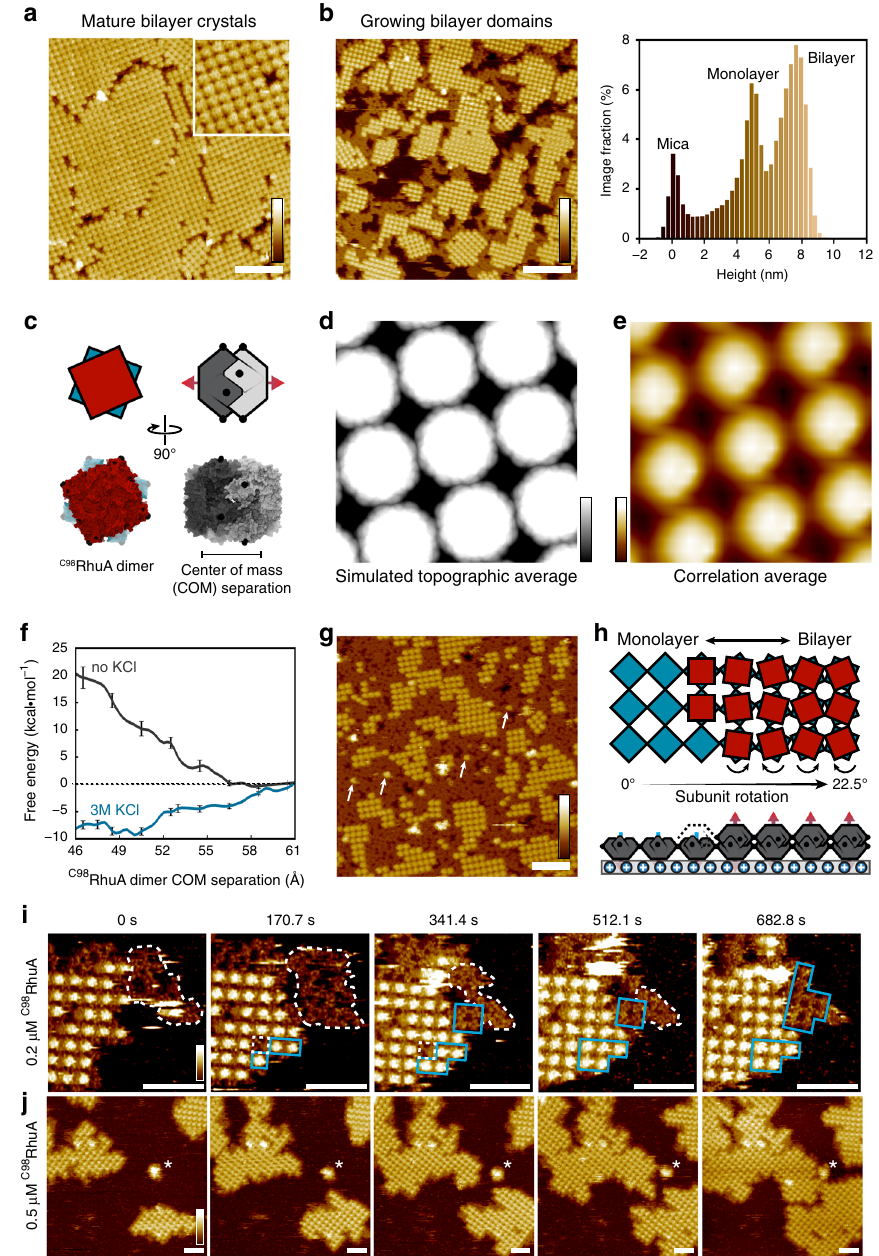
Fig. 3 Hierarchical self-assembly of bilayer C98 RhuA crystals. High-resolution AFM images of a , mature and b , growing bilayer crystals (0.4 – 0.5 μ M C98 RhuA), with image height value histogram shown on right. c C98 RhuA dimer structure. d Simulated and e , experimental average topographs for the bilayer structure. f Potential of mean force for C98 RhuA dimerization in the presence/absence of 3 M KCl. Error bars: s.e. of the free-energy gradient, as calculated using the block-averaging method ( “ Methods ” ). g Self-assembly of 5 μ M C98 RhuA, resulting in disordered monolayers which cannot template bilayer domains. Isolated 2nd layer monomers (arrows) are rare outside of crystalline domains. h Proposed self-templated growth mechanism for bilayer crystals. i N-term up C98 RhuA monolayers grow via nonclassical amorphous (white contour)-to-crystalline (blue regions) transitions at edges, which subsequently template second layer growth through classical (monomer-by-monomer) addition. j Bilayer growth kinetics are limited by the growth rate of the fi rst layer. Scale bars (white): 100 nm ( a / b / g ), 50 nm ( i / j ). Height ranges (gradient): 10 nm ( a / b / j ), 2 nm ( d ), 4 nm ( e ), 12 nm ( g ), 8 nm ( i